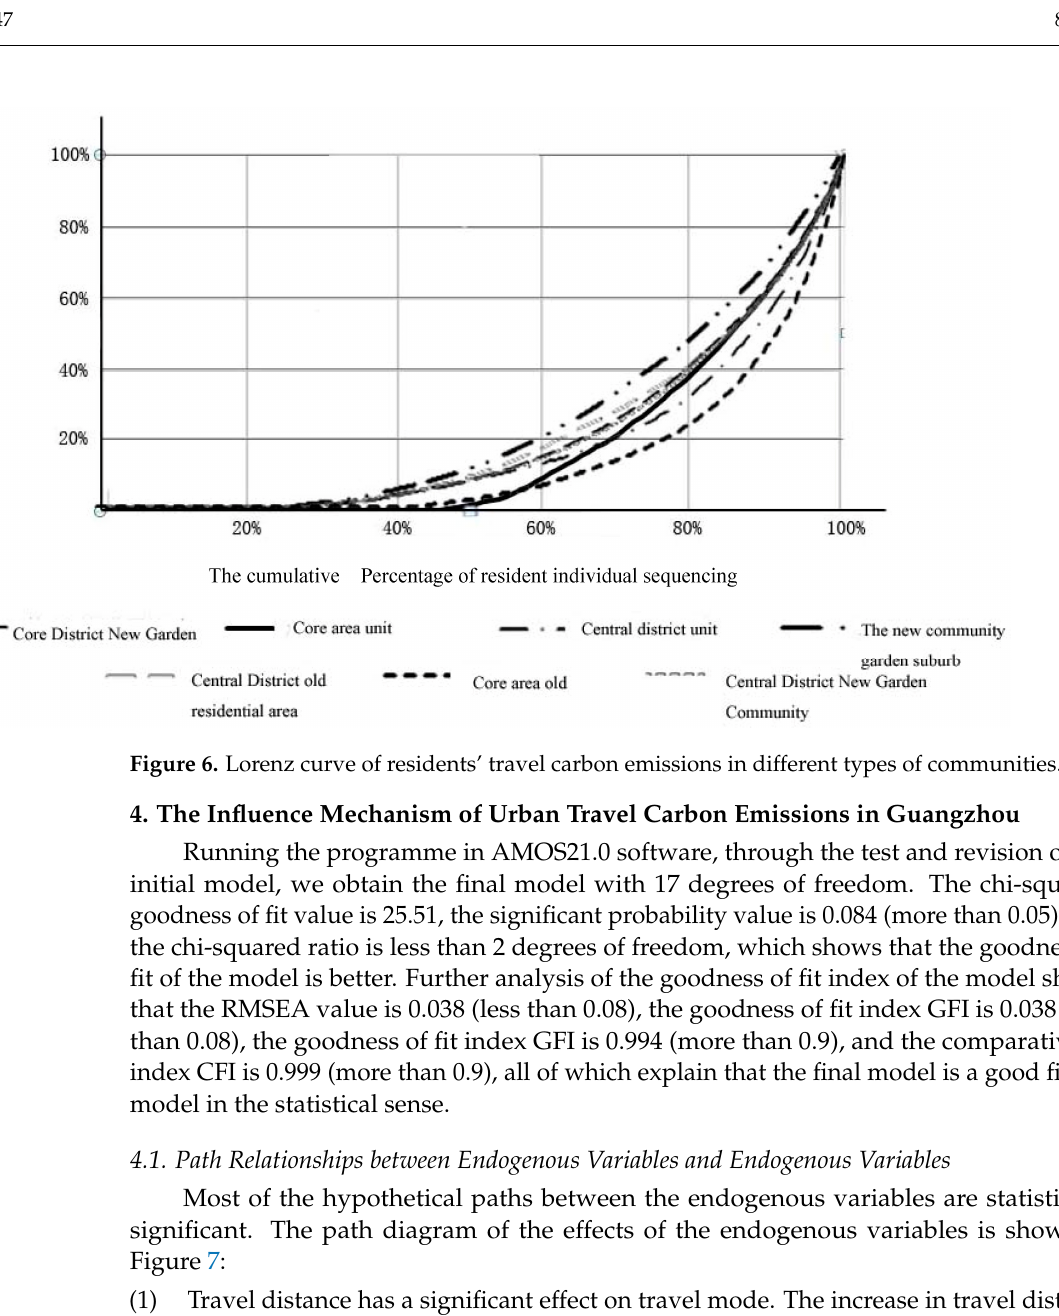
initial model, we obtain the final model with 17 degrees of freedom. The chi-squared goodness of fit value is 25.51, the significant probability value is 0.084 (more than 0.05), and the chi-squared ratio is less than 2 degrees of freedom, which shows that the goodness of that the RMSEA value is 0.038 (less than 0.08), the goodness of fit index GFI is 0.038 (less than 0.08), the goodness of fit index GFI is 0.994 (more than 0.9), and the comparative fit model in the statistical